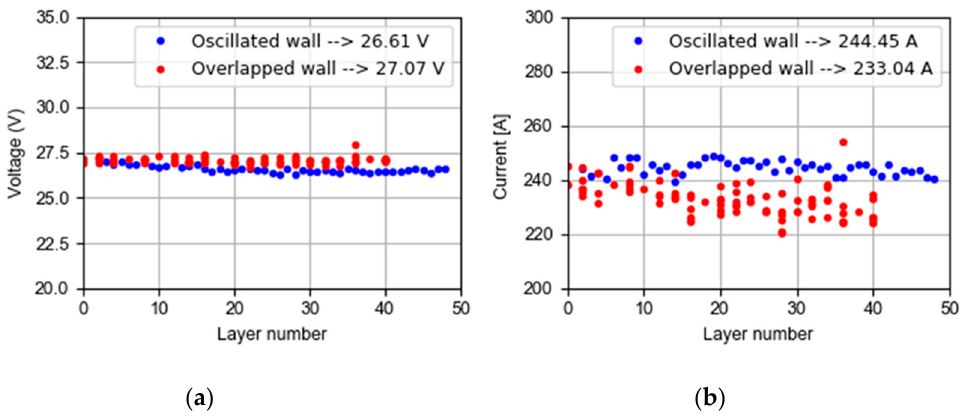
Figure 4. Mean current (a) and voltage (b) during additive manufacturing of each layer.